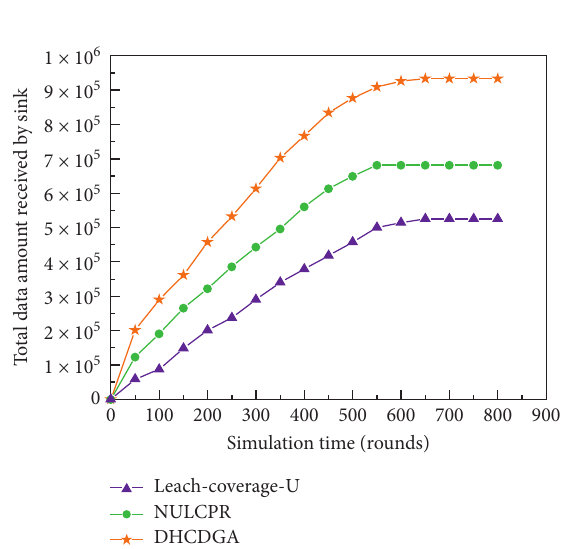
Figure 9: Total amount of data received by sink.